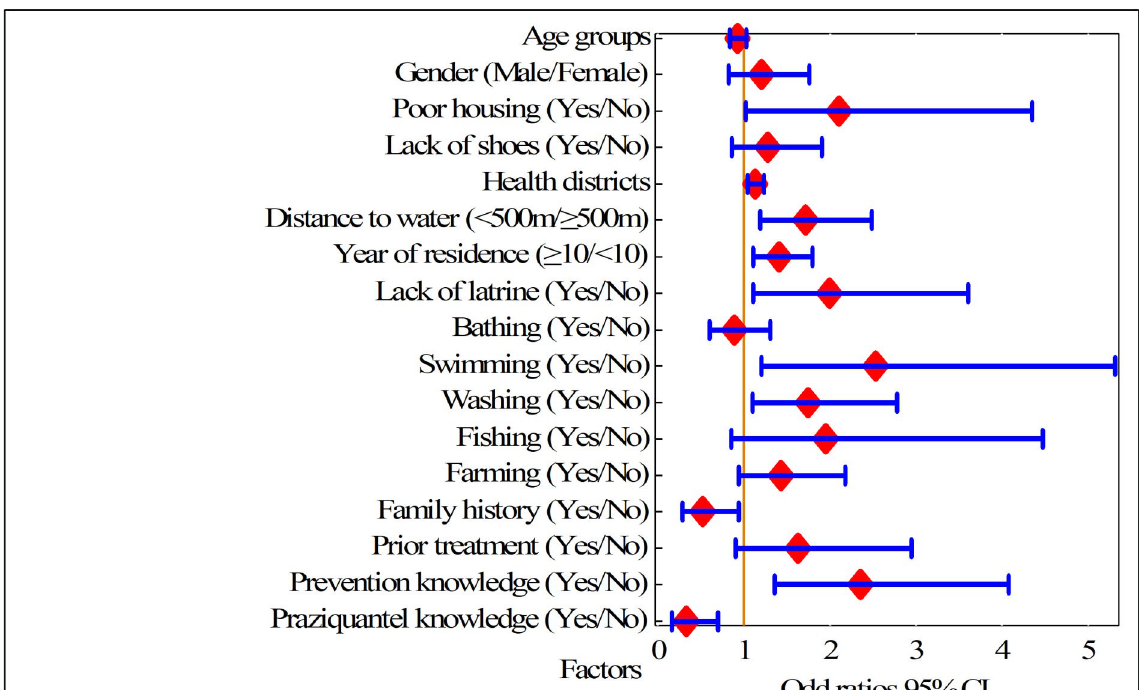
Fig 9. Results of multivariable logistic regression analysis for S . mansoni infection in 2017. Risk analysis performed for participants from 12 villages in Ituri province (n = 707). Adjusted Odds ratios, large red diamond and 95% confidence interval (CI), range indicated by horizontal blue